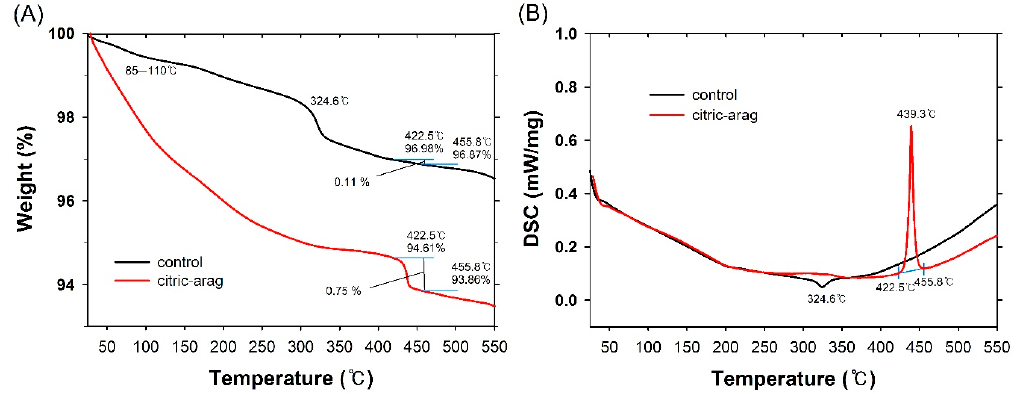
Figure 8. Thermogravimetric and differential scanning calorimetry (TG-DSC) results of the control and citric-arag samples. ( A ) Weight-loss curves and ( B ) DSC profiles.